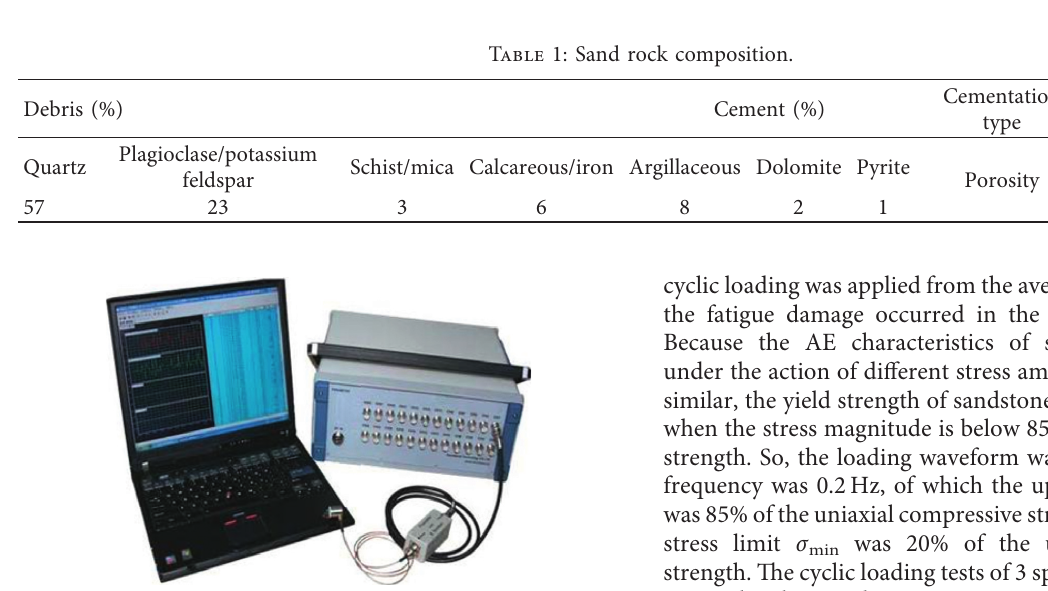
Figure 4: SAEU2S multichannel acoustic emission signal mea- surement system.